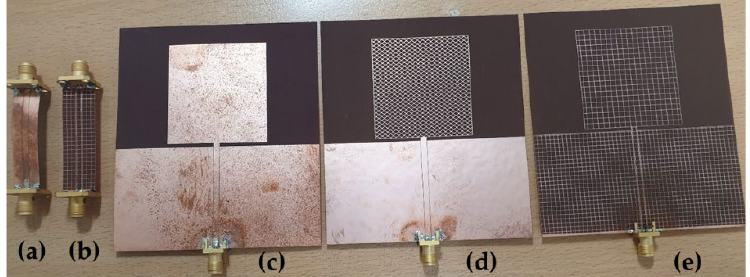
Figure 2. Manufactured CPWs, antennas; in order from the left of the photo: ( a ) solid CPW; ( b ) square-meshed CPW; ( c ) solid monopole antenna; ( d ) diamond-meshed monopole antenna with solid feedline; ( e ) square-meshed monopole antenna with meshed feedline.